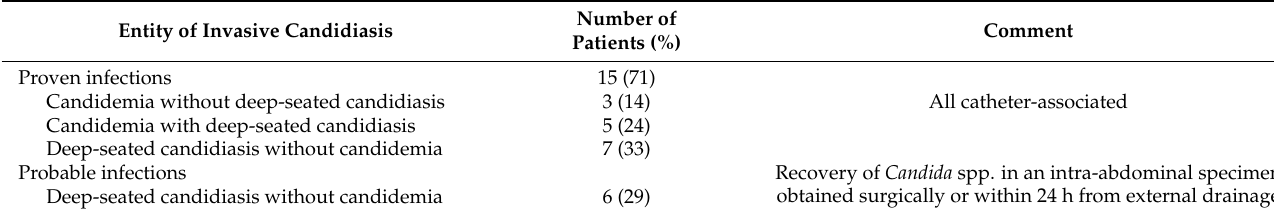
Table 6. Patients with Invasive Candidiasis.